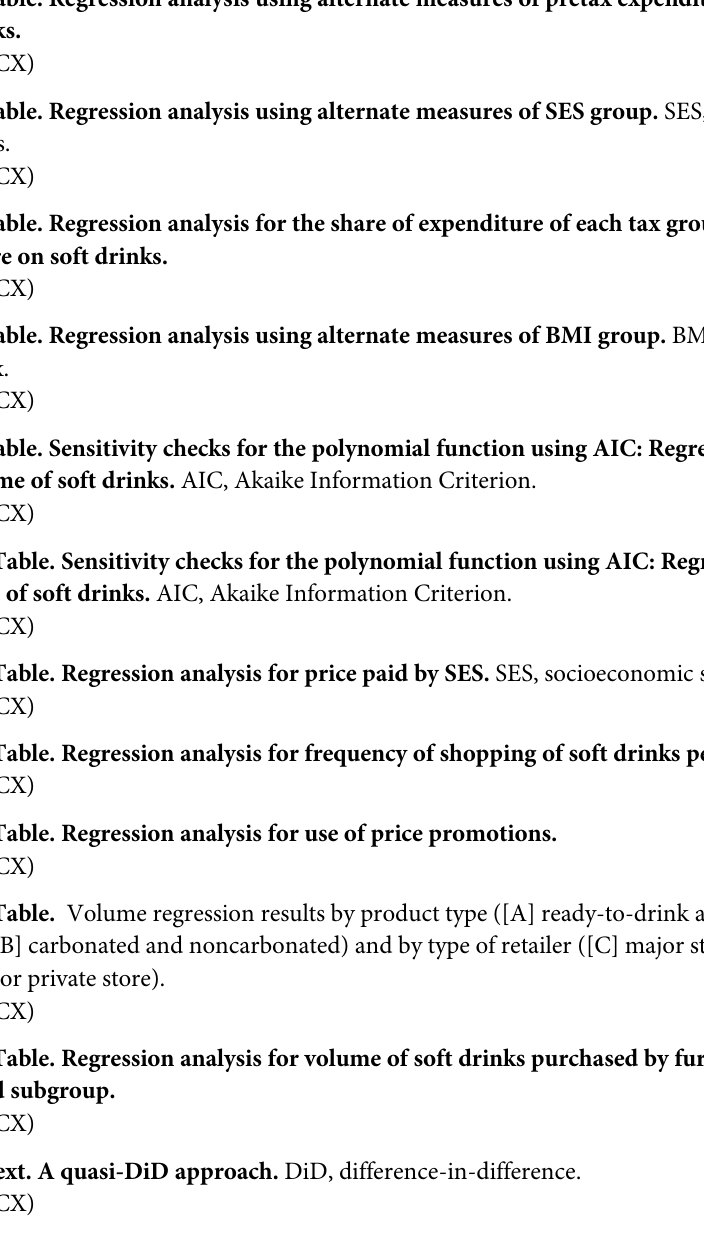
S3 Table. Descriptive statistics by SES group. SES, socioeconomic status. S4 Table. Changes in volume of soft drinks purchased after the policy announcement. S5 Table. Regression analysis using alternate measures of pretax expenditure of soft drinks. S6 Table. Regression analysis using alternate measures of SES group. SES, socioeconomic